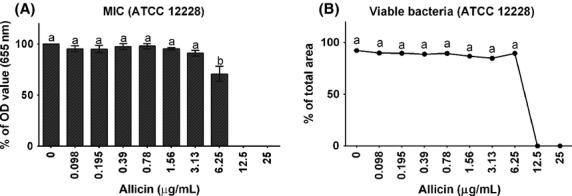
Minimum inhibitory concentration (mean ± SEM) of allicin determined in Staphylococcus epidermidis ATCC 12228 growing in planktonic cultures. (A) Results obtained with the standard CLSI broth dilution protocol; (B) Results (mean ± SEM) obtained with a live/dead staining and quantification of dead and live bacteria with confocal microscopy. Different lower-case letters (a, b) indicate significant differences (P < 0.001) between allicin concentrations.